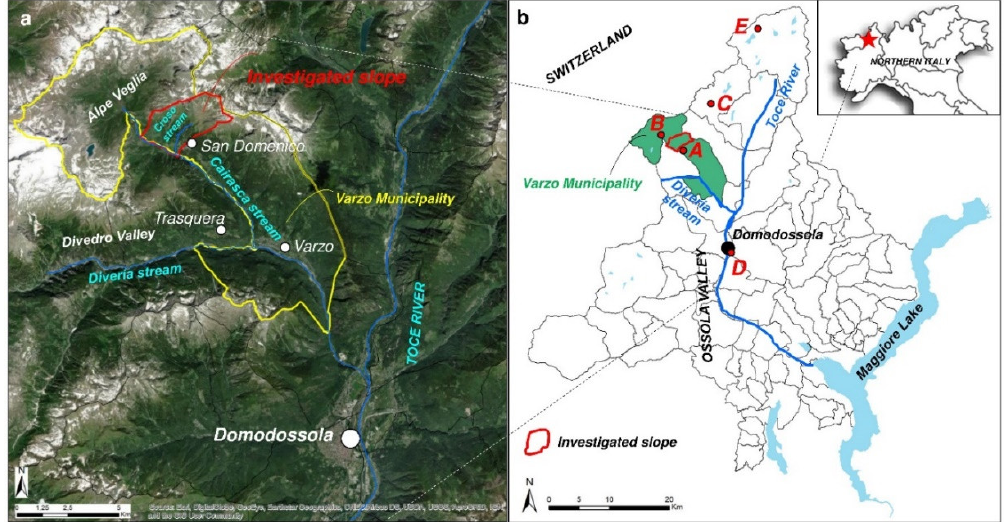
Figure 1. The geographical setting of the study area. ( a ) The investigated slope within the Cairasca stream hydrographic basin; ( b ) the investigated slope in the context of the Verbano-Cusio-Ossola province with the distribution of the meteorological stations (see codes and details in Table 1). Background of a: Environmental Systems Research Institute (ESRI) DigitalGlobe & GeoEye (GIS User commonly; http://microsites.digitalglobe.com/arcgis/).